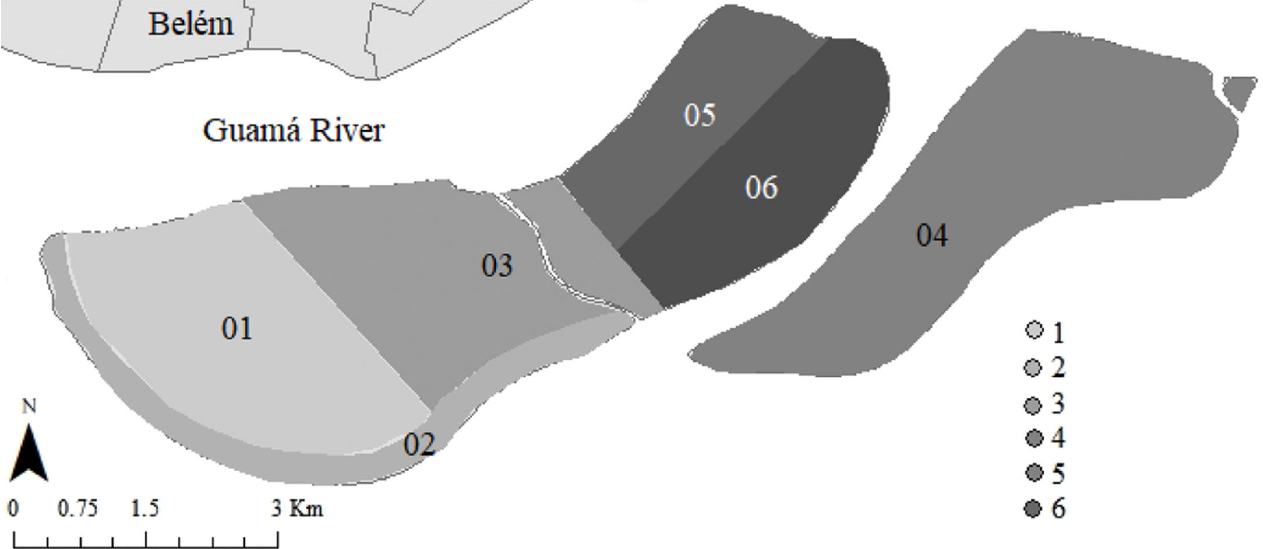
Figure 2. Geographic location of the island investigated in Belém, state of Pará, Brazilian